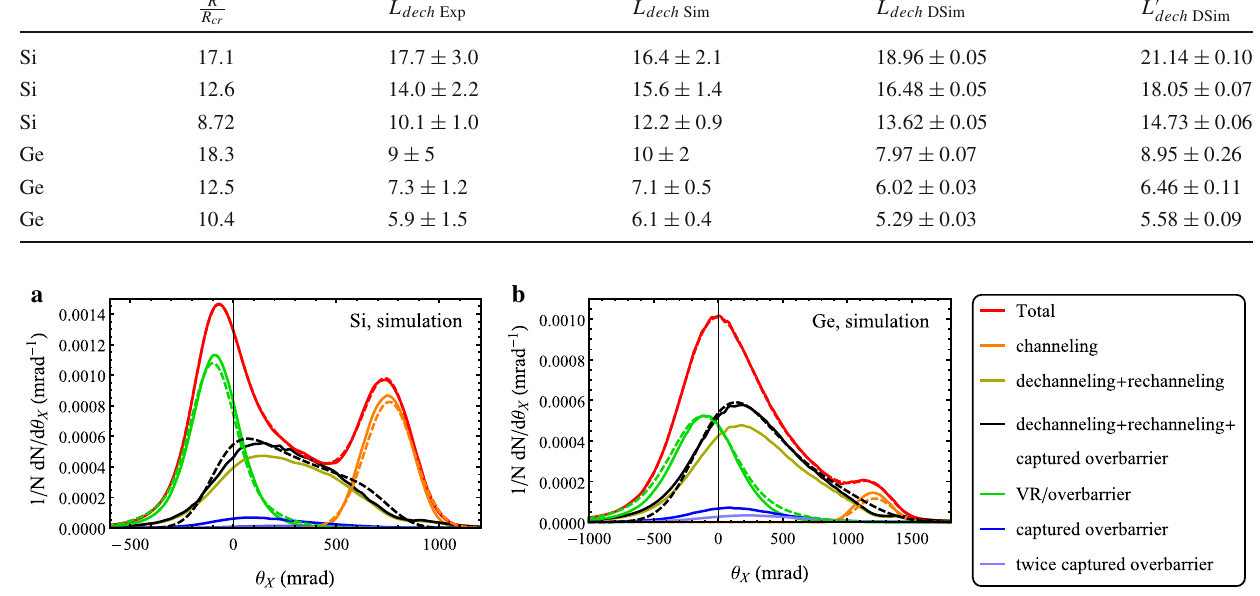
Fig. 7 Simulated distributions of deflected beam by Si (left) and Ge (right) crystals, bent at 750 µ rad and 1200 µ rad respectively, and the channeling, dechanneling, initially overbarrier, overbarrier, captured under and escaped the channeling mode one and two times (captured